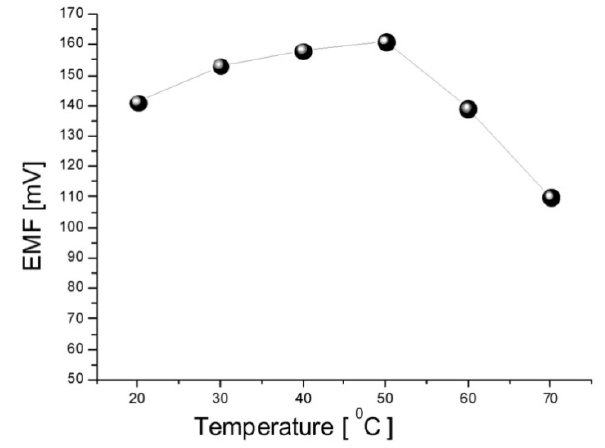
Figure 4. Calibration curve illustrated the influence of the temperature on the sensor